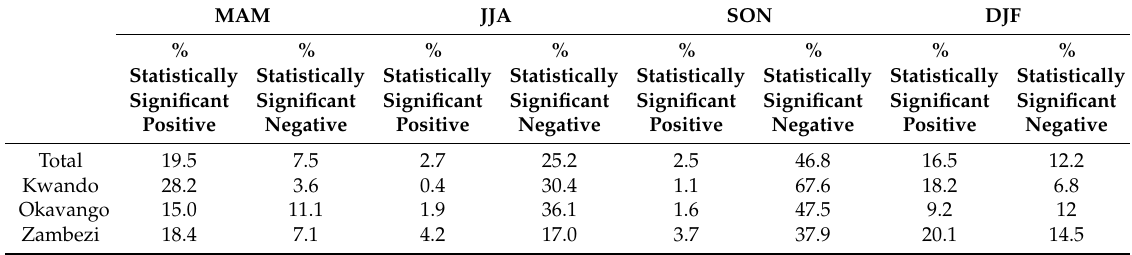
Table 1. Percentage of study area, by basin, with statistically significant trends in directional persistence of NDVI for 1982–2010 time series by season. The critical value of directional persistence ( α = 0.025) is ±